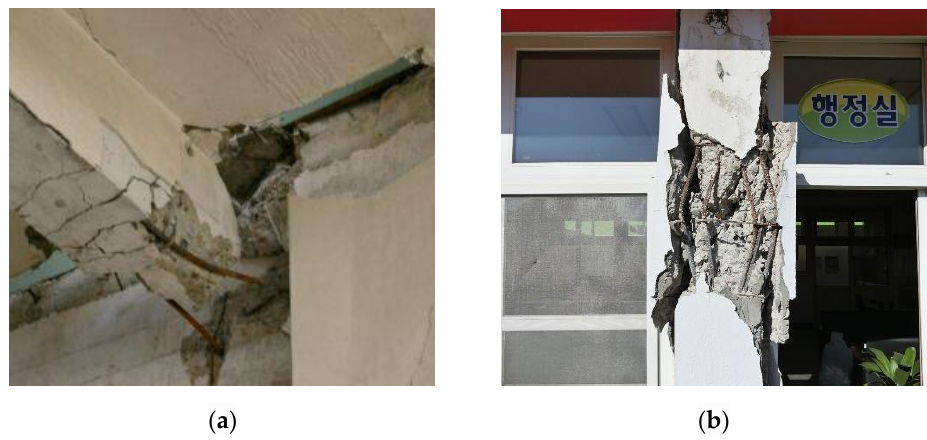
Figure 3. Corrosion of RC beams and columns damaged during earthquakes. ( a ) the 2004 Niigta-ken Chuetsu Earthquake in Japan and ( b ) the 2017 Pohang Earthquake in Korea.